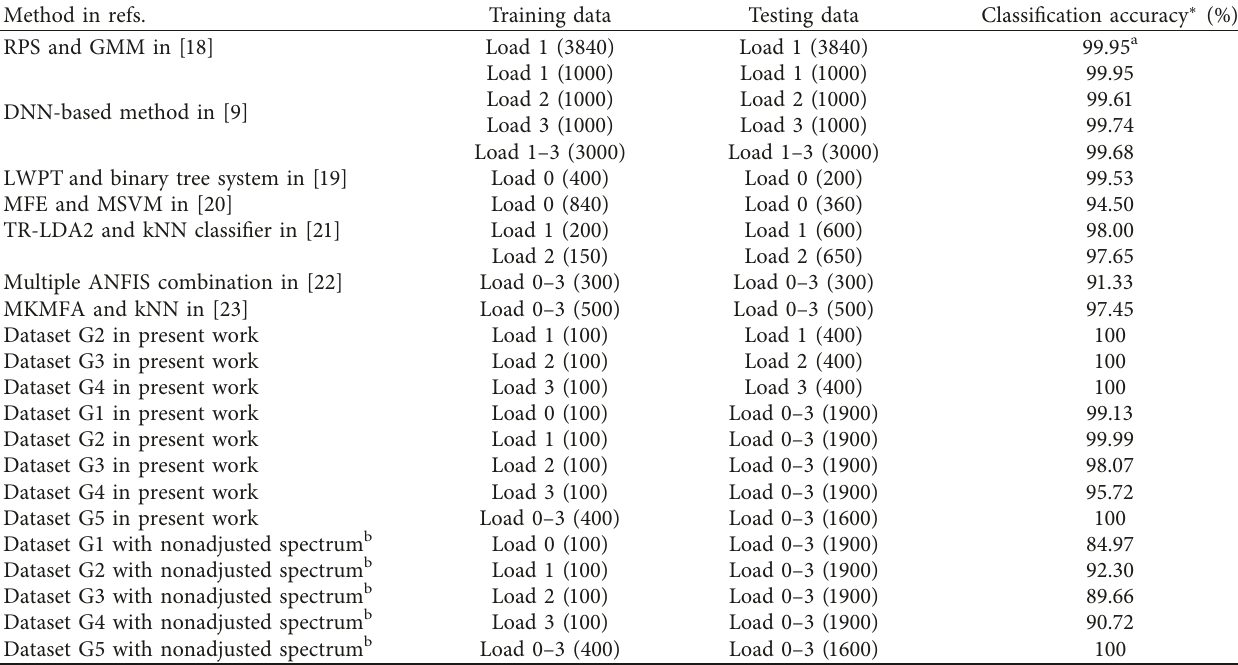
Table 10: Comparisons for multiclass fault detection between current work and some published work. Method in